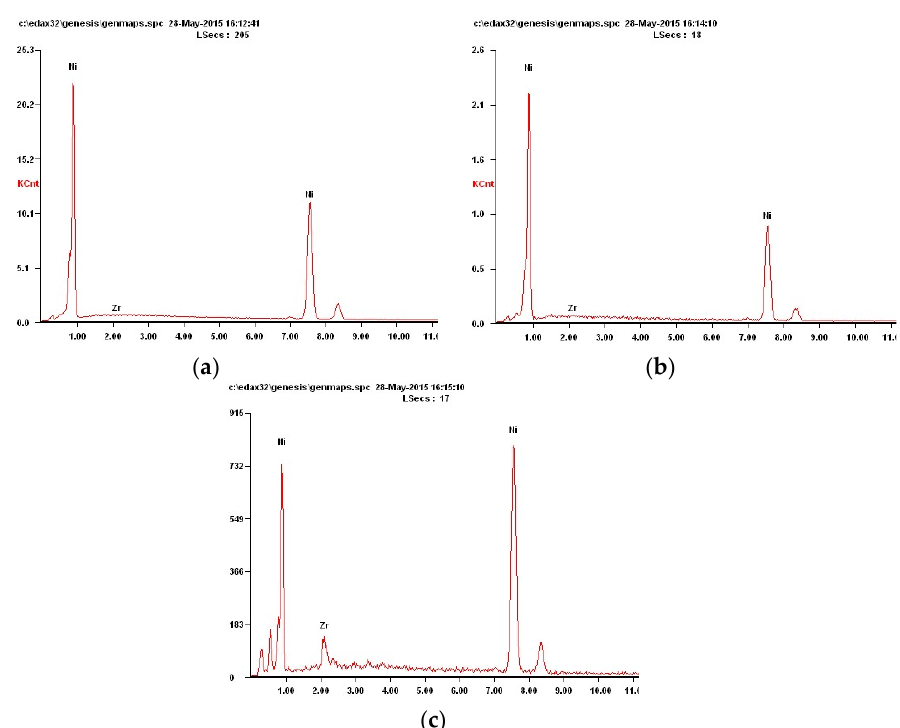
Figure 4. Point scan element curves of Ni/ZrO 2 gradient coating. ( a ) EDS plot at point A; ( b ) EDS plot at point B ( c ) EDS plot at point C.